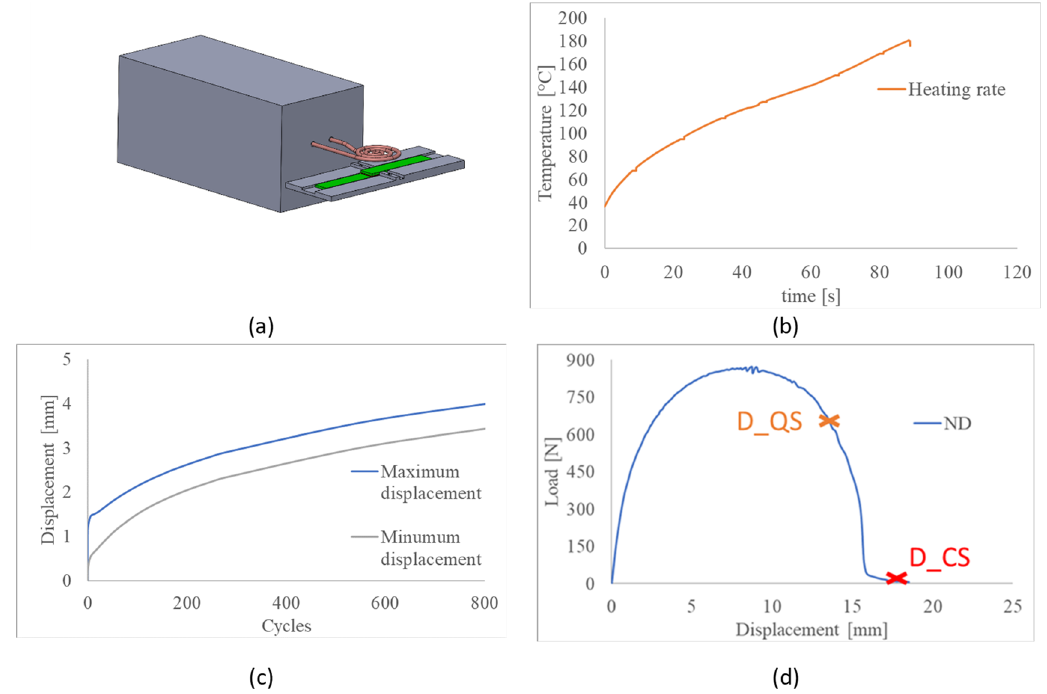
Figure 1. ( a ) Healing configuration; ( b ) heating rate of the SLJ; ( c ) maximum displacement obtained during the fatigue tests; ( d ) points where the test were interrupted for the tests D_QS and D_CS. ( d ) points where the test were interrupted for the tests D_QS and